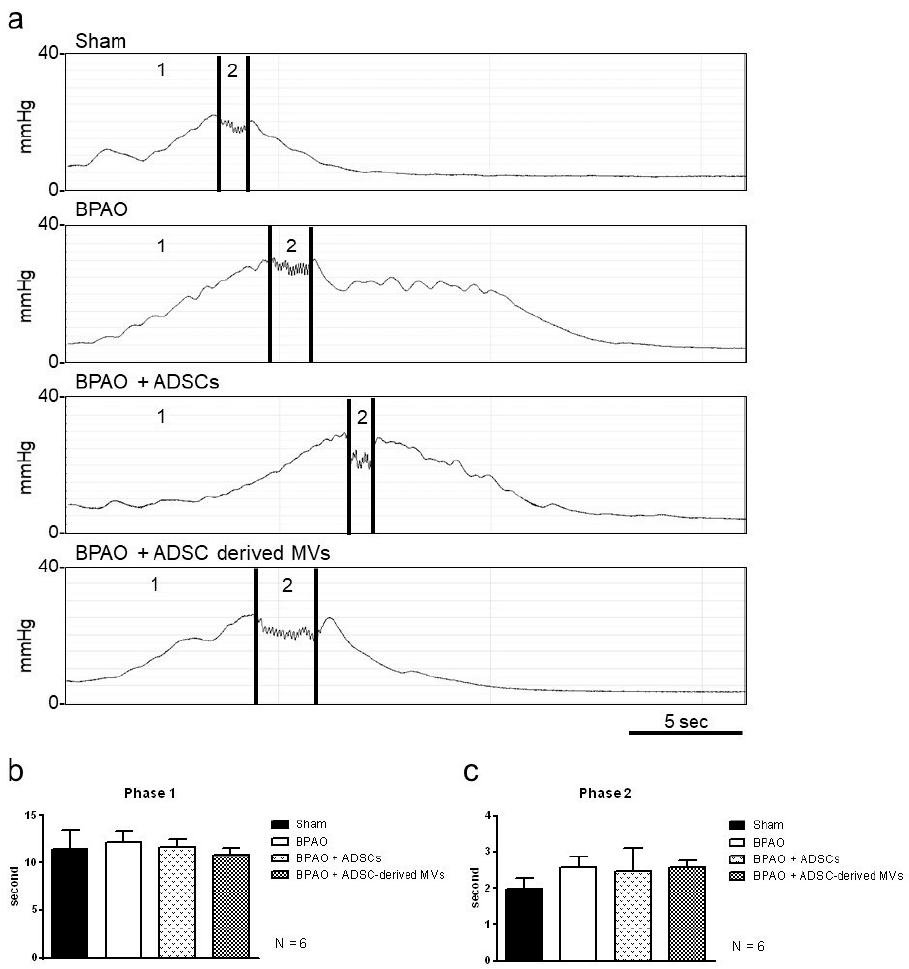
Figure 5. Micturition contraction patterns on transcystogram study in separated group. In the top panel, ( a ) demonstrated the micturition contraction patterns on transcystometrogram. In the bottom panel, ( b , c ) showed that the duration of phasic 1 contraction and phasic 2 HFO were of no significant differences between groups. The detailed data are shown in Table 3. Table 3. The duration of phasic 1 and phasic 2 micturition contraction on transcystometrogram. Data are presented as mean ± standard deviation; the 95% confidence intervals are shown in brackets. * p < 0.05 vs. sham group by two-tailed non-paired Student’s t -test. # p < 0.05 vs. BPAO group by two-tailed non-paired Student’s t -test.